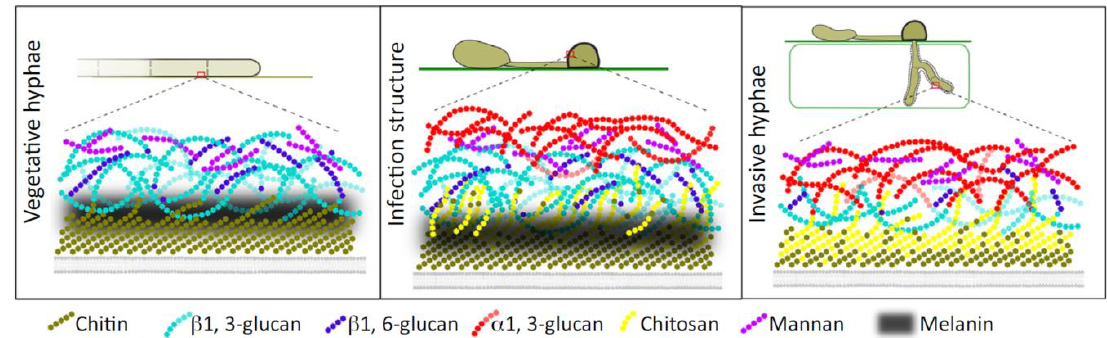
Figure 3. Changes in the structure of the fungus cell wall during plant infection, according to Geoghegan et al. [117].